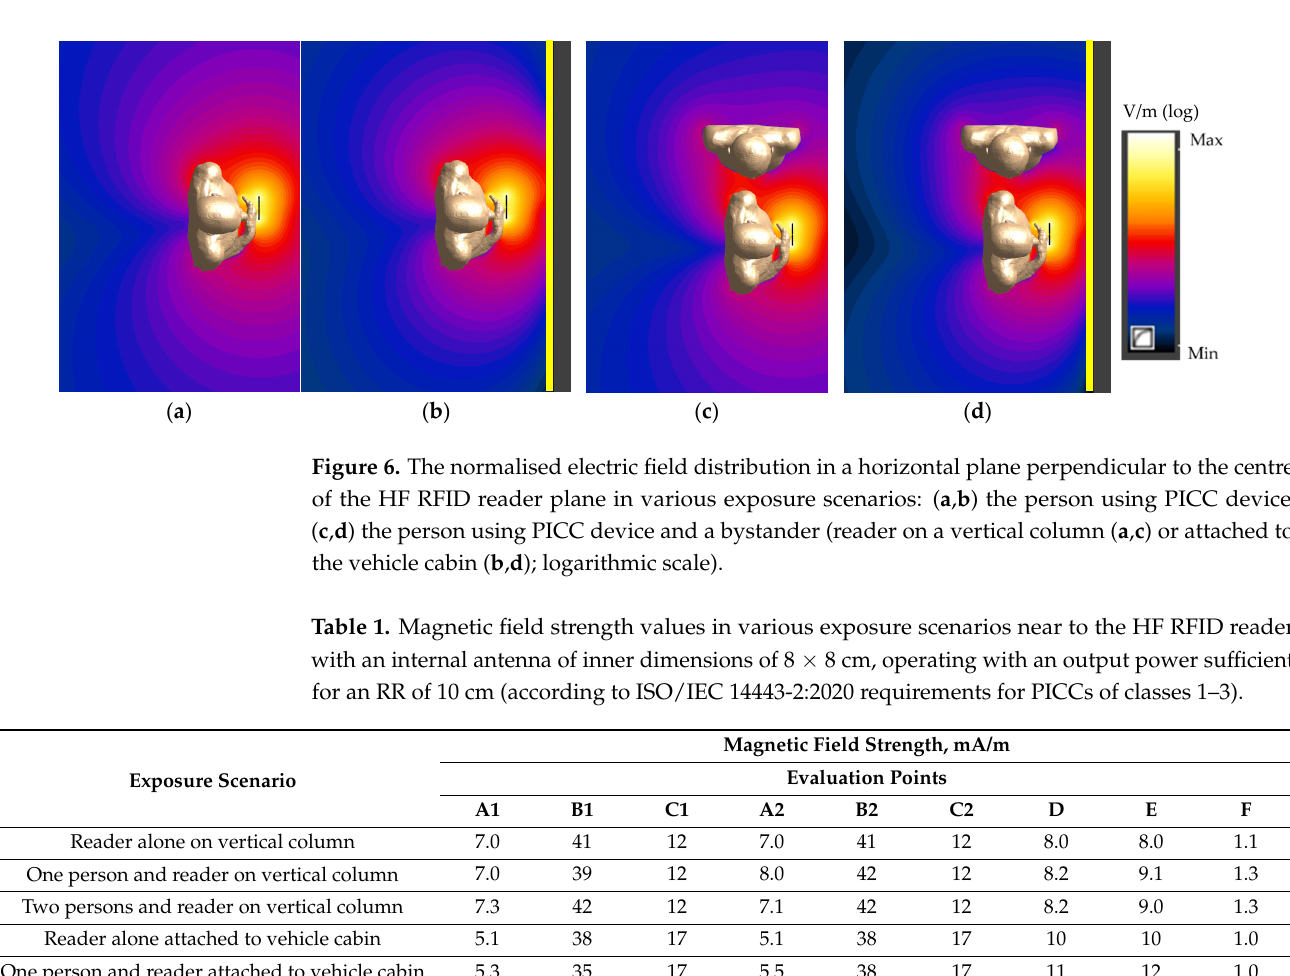
Figure 5. The normalised magnetic field distribution in a plane perpendicular to the centre of the HF RFID reader plane in various exposure scenarios: ( a , b , e ) the person using PICC device; ( c , d ) the person using PICC device and a bystander (reader on a vertical column ( a , c,e ) or attached to the vehicle cabin ( b , d ); horizontal ( a – d ) and vertical ( e ) cross-section; logarithmic scale).